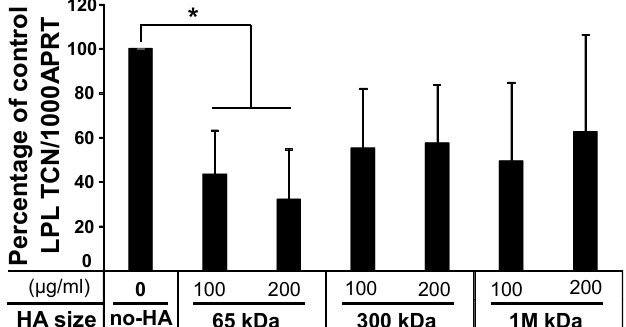
Figure 4. Decreased percentage of adiogenesis by LMW-HA treatment. LPL (terminal adipogenesis marker) was analysed by treatment of hyaluronan fragments (41–65 (65 kDa), 151–300 (300 kDa) and 1010–1800 (1 MDa)) in ADM compared to the no-HA control. Results are given as a percentage of the no-HA control (control as 100%) in LPL Transcript Copy Number (TCN) / 1000 APRT. * p < 0.05.